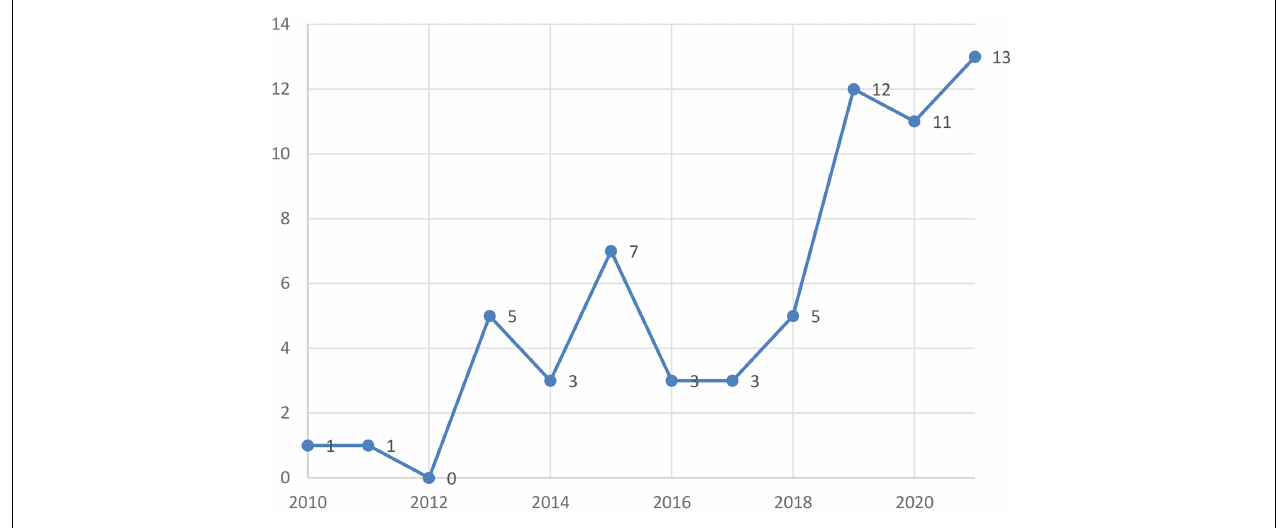
FIGURE 2 | Data distribution of AIEL articles from 2010–2021.